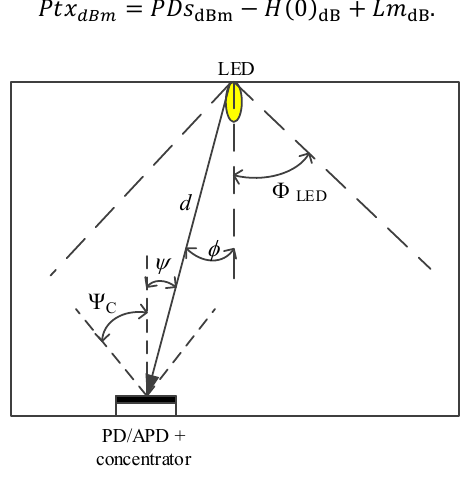
Figure 1 VLC LOS DC gain model